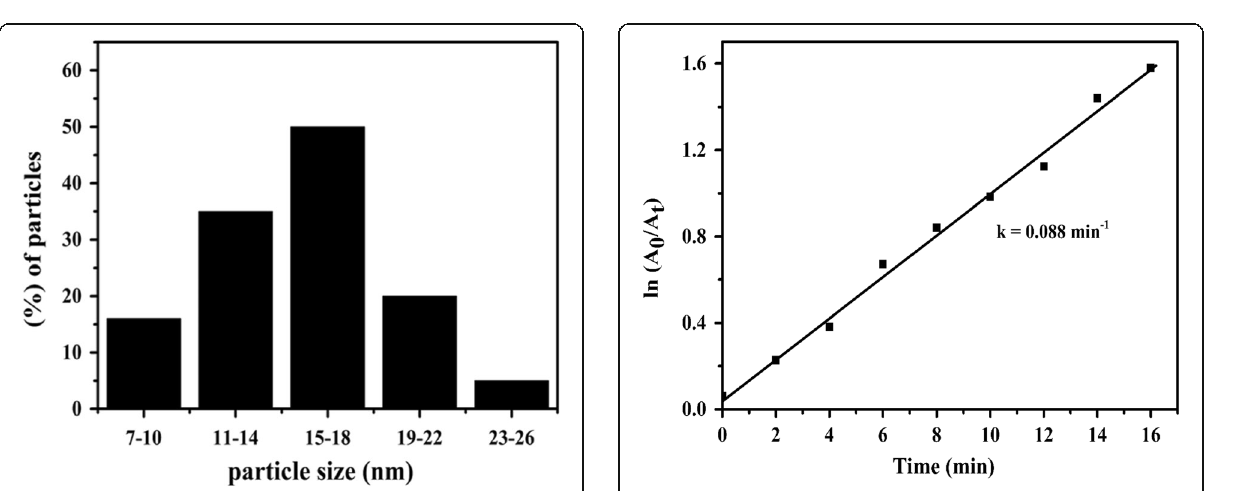
Fig. 7 Histogram showing the particle size distribution of papaya leaf extract capped gold